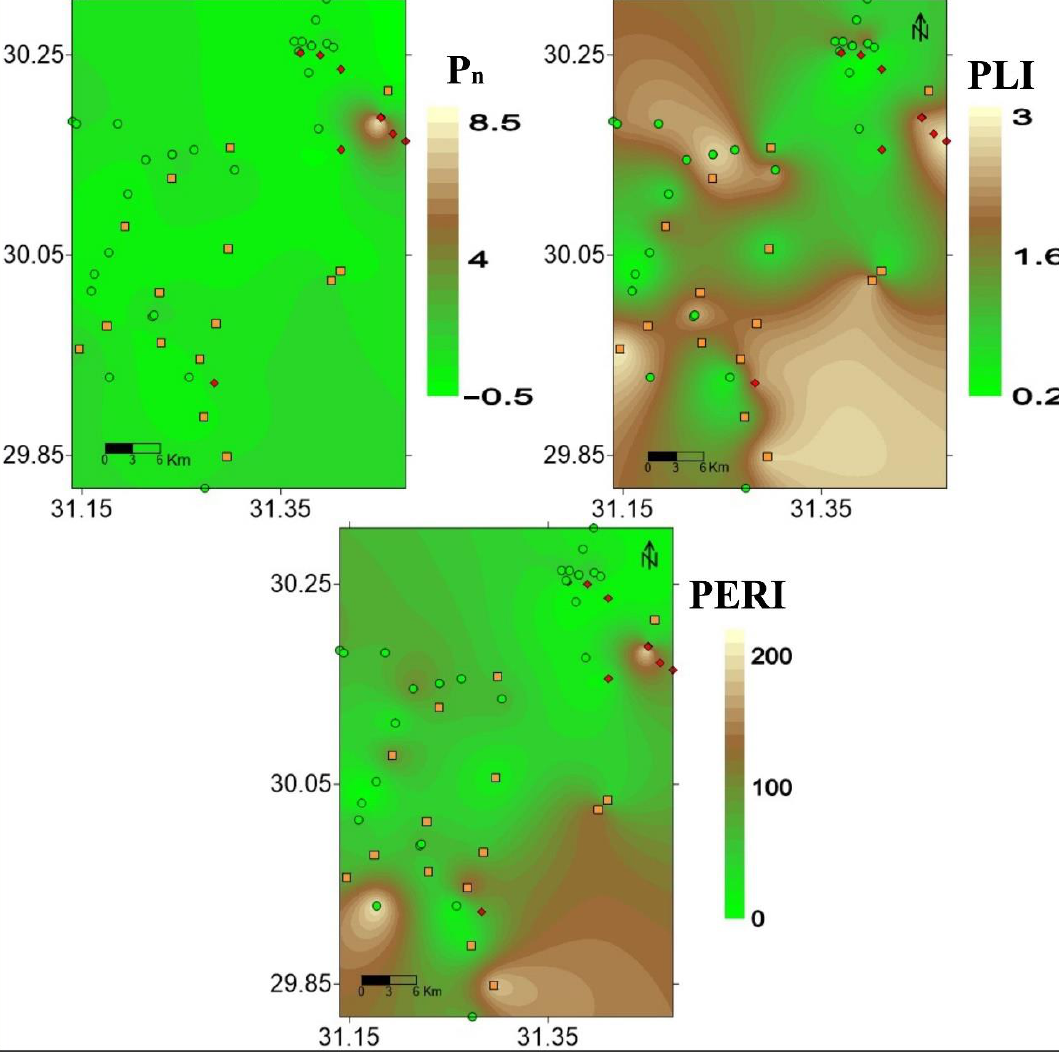
The bulk magnetic susceptibility values (k) range between 0.15 and 3.56 × 10 − 3 ,